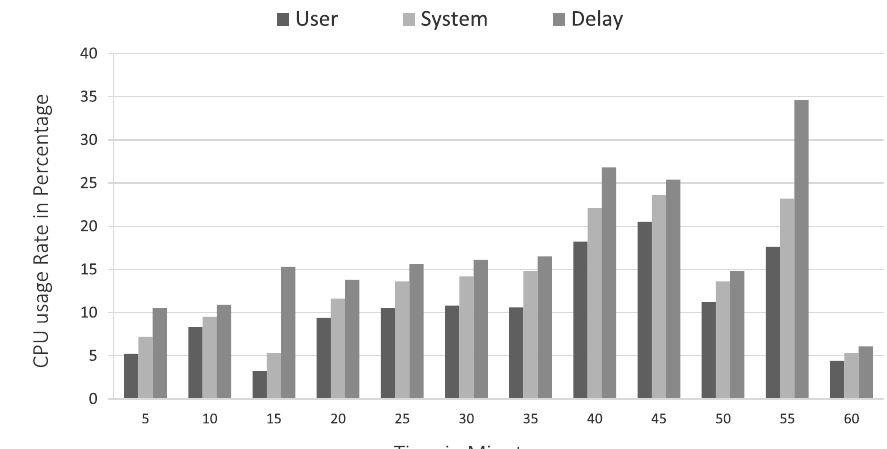
Fig. 21 CPU usage rate in percentage measurement in the (Ad‑hoc Cloud Server) within 60